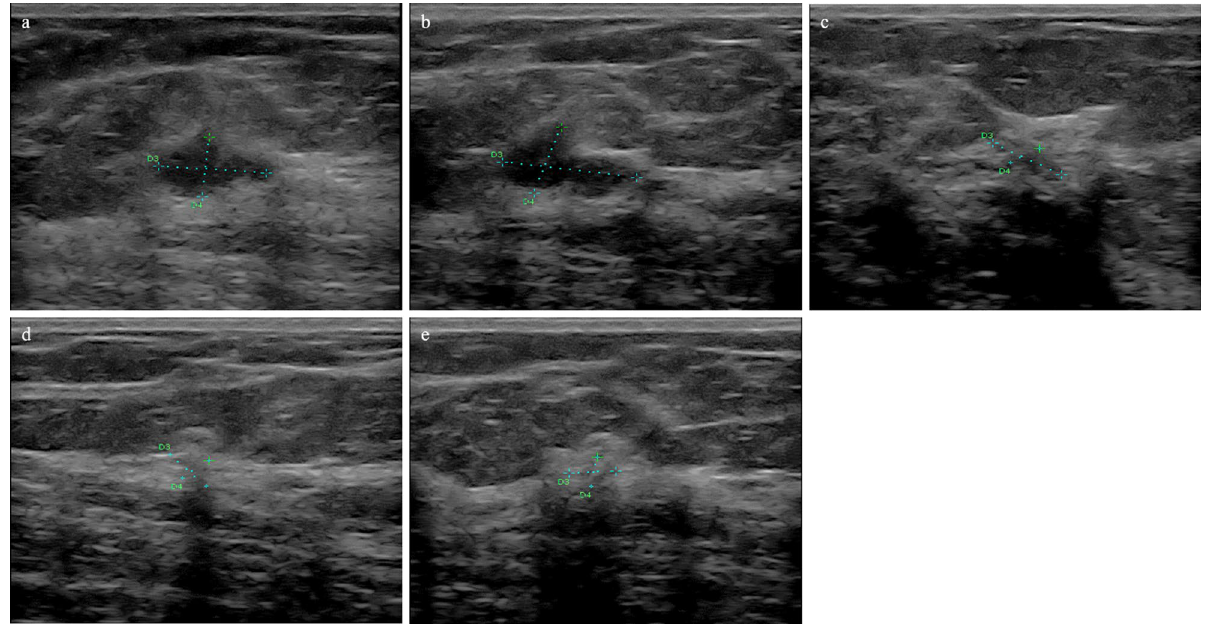
Figure 2. Ultrasound results from a 56-year-old patient with breast cancer (NST Grade 3, TNBC, Ki 67–30%). In B-mode examination ( a ) before treatment, the tumour was hypoechoic. After the first ( b ), second ( c ), third ( d ), and fourth ( e ) course of the NAC, the echogenicity increased (histopathological verification: RT, RMC =